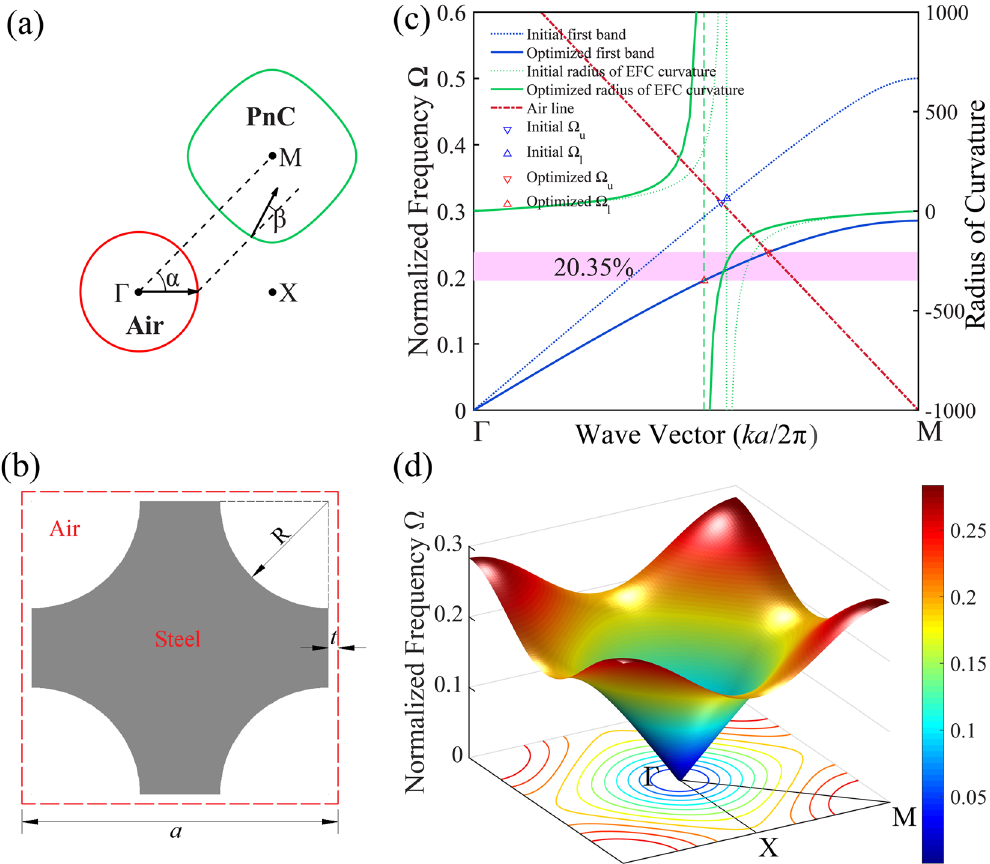
Figure 1. ( a ) Schematic demonstration of negative refraction. Red and green lines denote EFC for air and PnC, respectively. The black arrows indicate directions of energy flow when acoustic waves enter PnC from air with the interface normal parallel to Γ M . ( b ) The unit cell of the optimized PnC with square lattice constant a . The grey and white denote steel and air respectively. ( c ) The first phononic band of the initial (dotted blue line) and optimized (solid blue line) structure, initial (dotted green line) and optimized (dashed green line) radius of EFC curvature of equifrequency contours along Γ M direction and dispersion relation in air which is shifted to M point (dashed red line). The initial and optimized upper and lower limit are indicated by blue and red triangles. ( d ) The complete 3D band structure and EFCs of the optimized